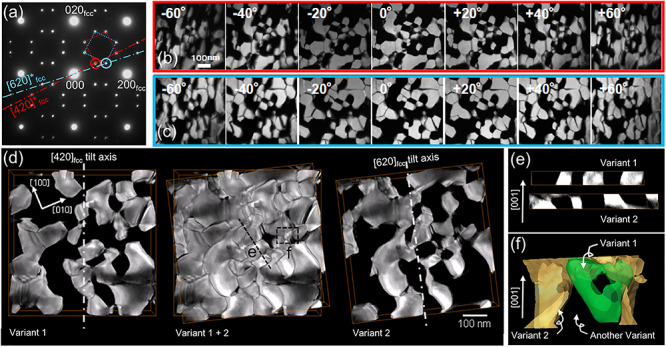
DF-TEM tomography observation of two orientation variants of tetragonal Ni4Mo domains in Ni–19.5 at.% Mo alloy [101]. (a) A [001] electron diffraction pattern explaining the two DF-TEM imaging conditions: gD1a=\documentclass[12pt]{minimal}
\usepackage{amsmath}
\usepackage{wasysym}
\usepackage{amsfonts}
\usepackage{amssymb}
\usepackage{amsbsy}
\usepackage{upgreek}
\usepackage{mathrsfs}
\setlength{\oddsidemargin}{-69pt}
\begin{document}
}{}$\frac{1}{5}$\end{document}(420)fcc excitation on the specimen-tilt axis for variant 1 and hD1a=\documentclass[12pt]{minimal}
\usepackage{amsmath}
\usepackage{wasysym}
\usepackage{amsfonts}
\usepackage{amssymb}
\usepackage{amsbsy}
\usepackage{upgreek}
\usepackage{mathrsfs}
\setlength{\oddsidemargin}{-69pt}
\begin{document}
}{}$\frac{1}{5}$\end{document}(260)fcc excitation for variant 2, (b) parts of DF-TEM tilt series for variant 1 (upper row) and variant 2 (lower row), (c) reconstructed 3D volumes of variant 1 (left), variant 2 (right) and their superposition (center), (d) 2D cross-sections of the reconstructed variant 1 and variant 2 along line A denoted in (c) and (e) a magnified 3D view of the superposition of variant 1 and variant 2 showing the existence of the other variant between them.